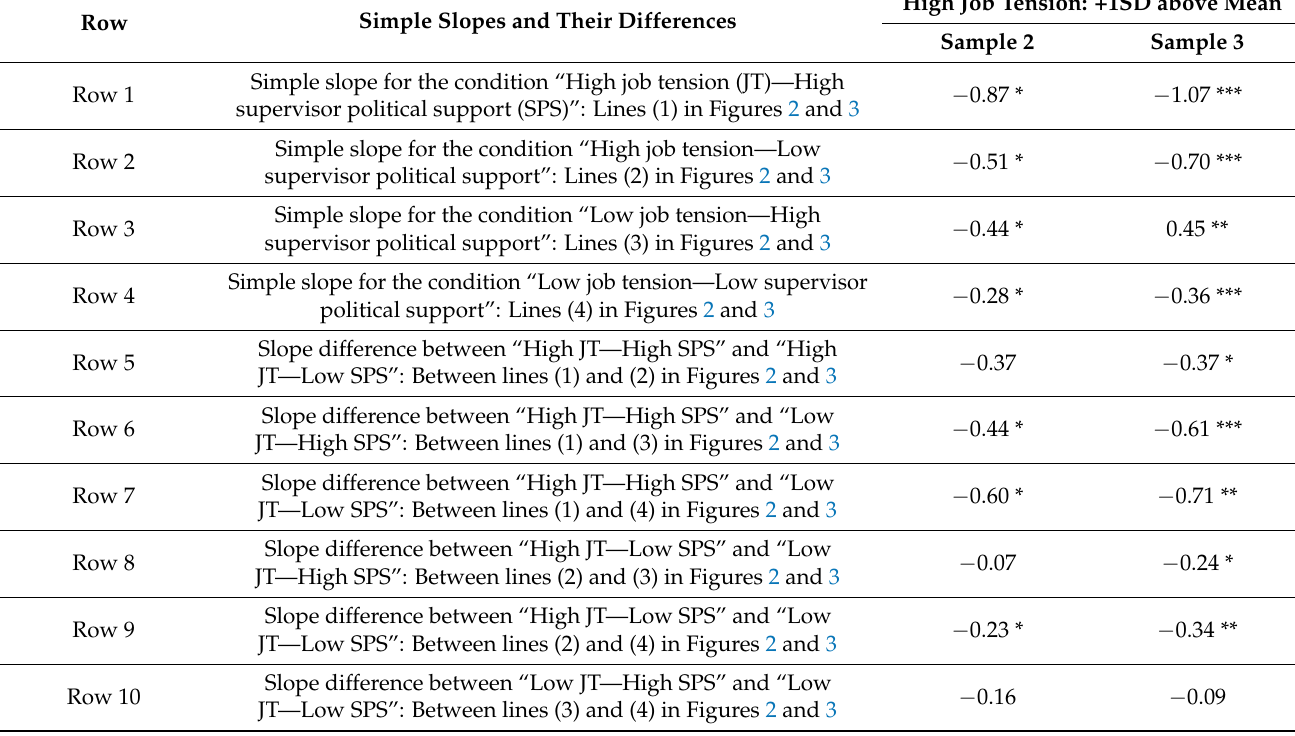
Figure 3. Sample 3: Three-way interaction of risk factors of work on psychological health, job tension, and supervisor political support predicting employee well-being. Note: Calculations are based on coefficients from Table 3 . Table 6. Slope difference tests of three-way interaction of risk factors of work on psychological health, job tension, and SPS predicting employee well-being. Note: From Figures 2 and 3